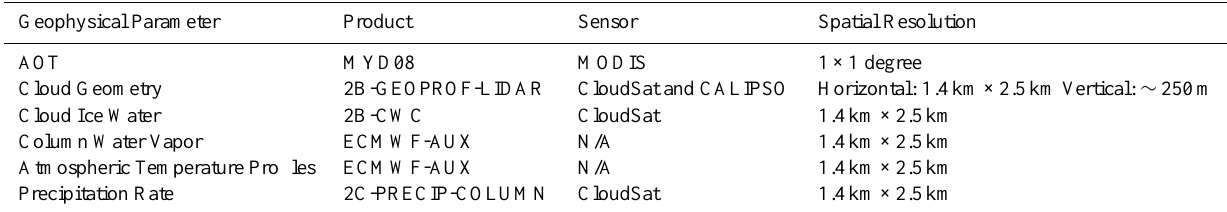
Table 1. Summary of satellite and model datasets employed in this study.